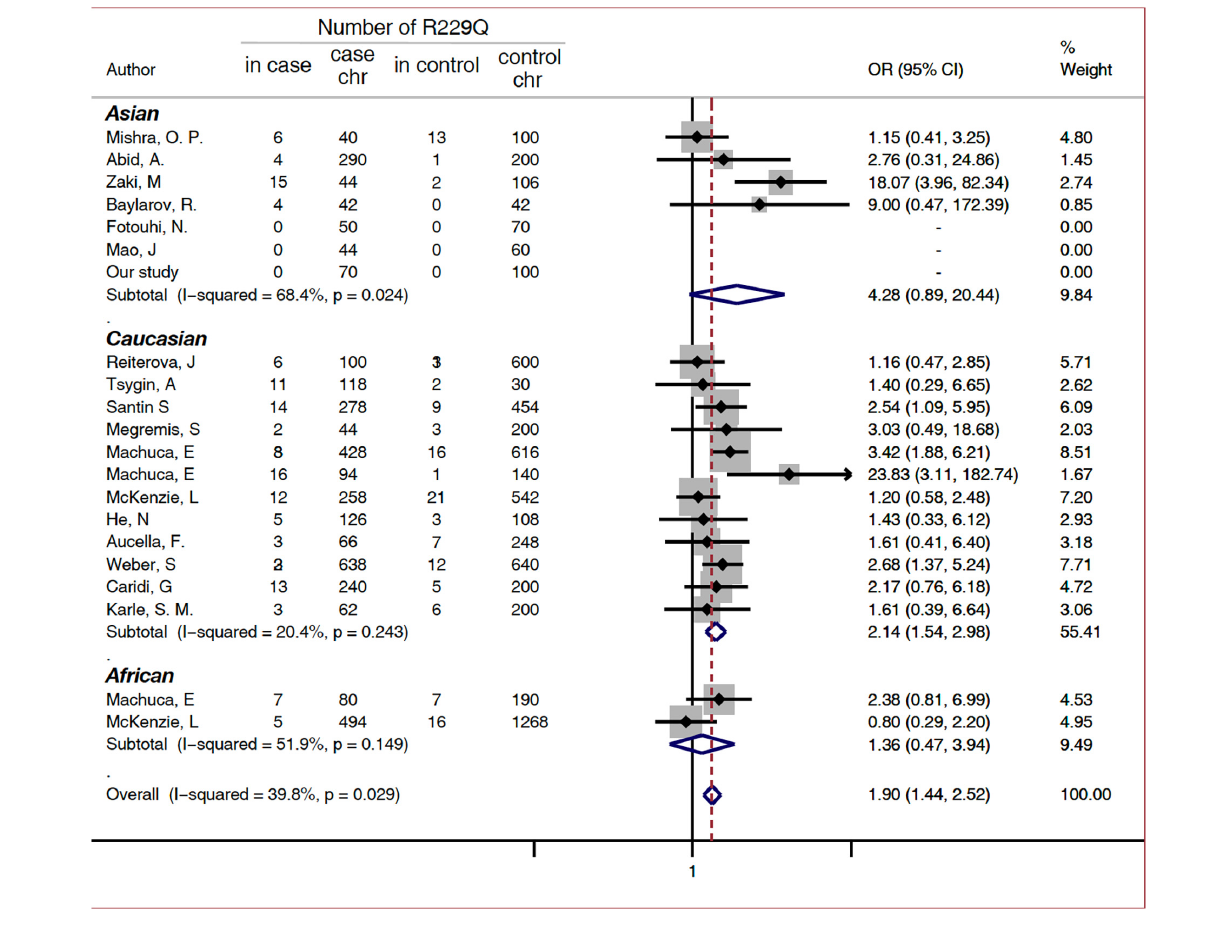
with one another, with a narrow range from 1.72 (95% CI: 1.32- 2.26) to 2.08 (95%CI: 1.49-2.91) ( Supplementary Figure 4 ). It indicated that our results were